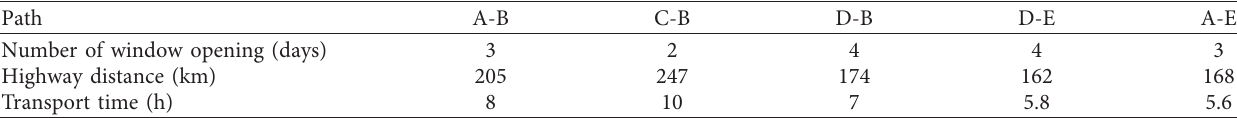
Table 2: Data on transport paths.